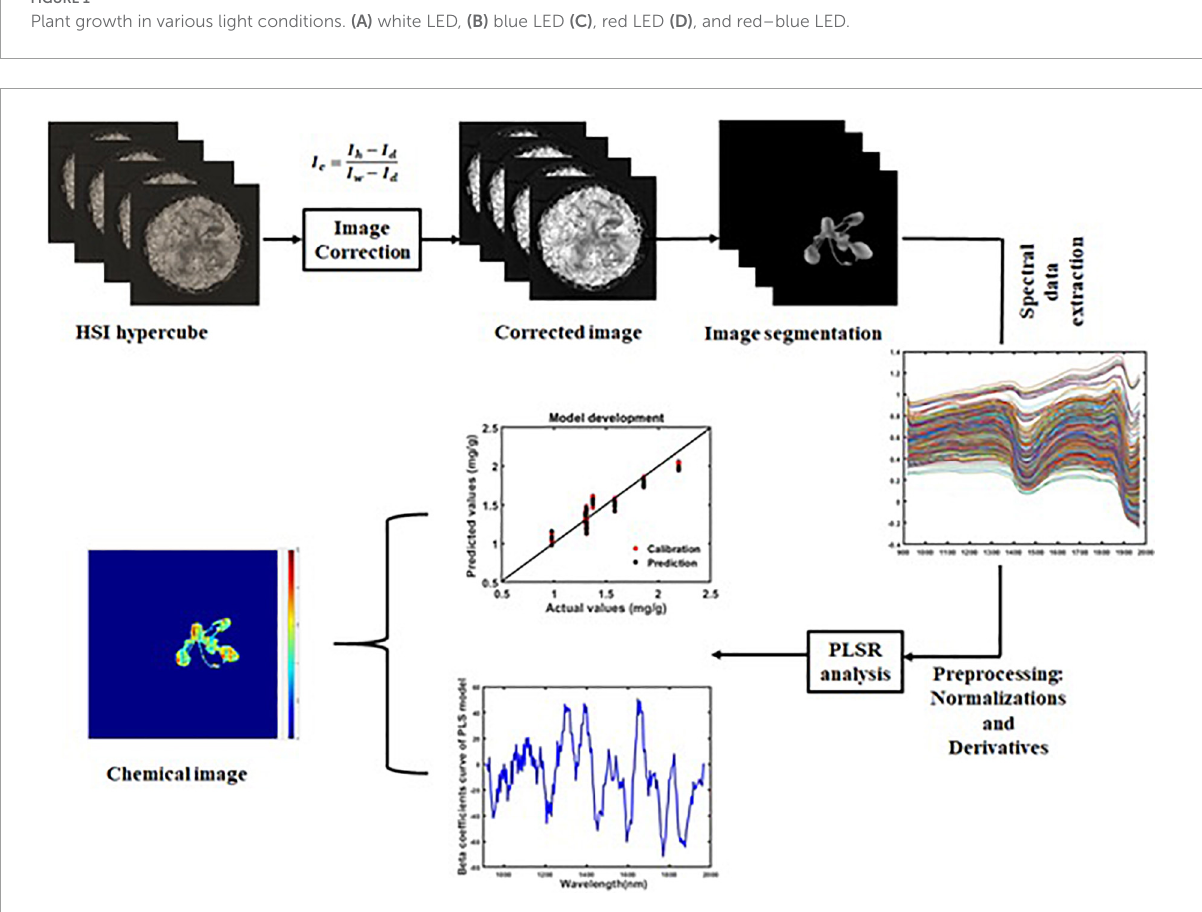
FIGURE2 Workflow of phenolic content prediction in